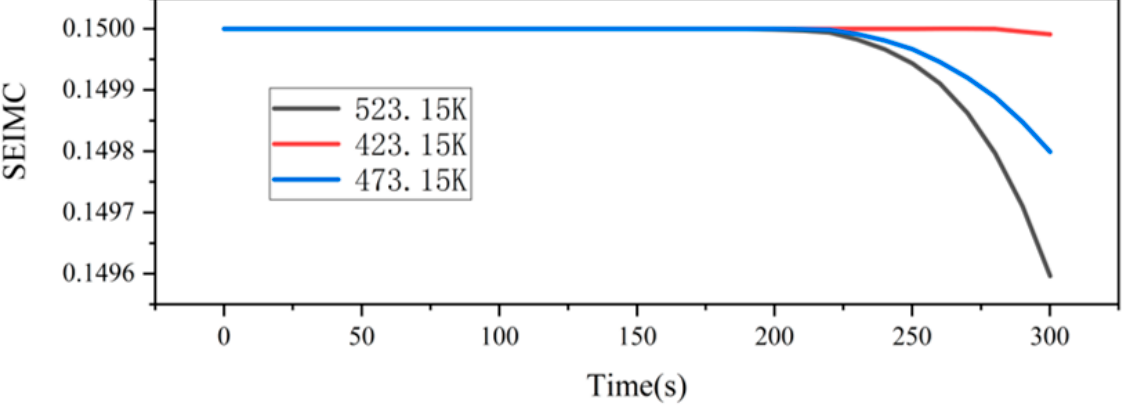
Figure 3. Conformational curves for changes in cell composition of SEI films at different temperatures in tests 1, 2, and 3.